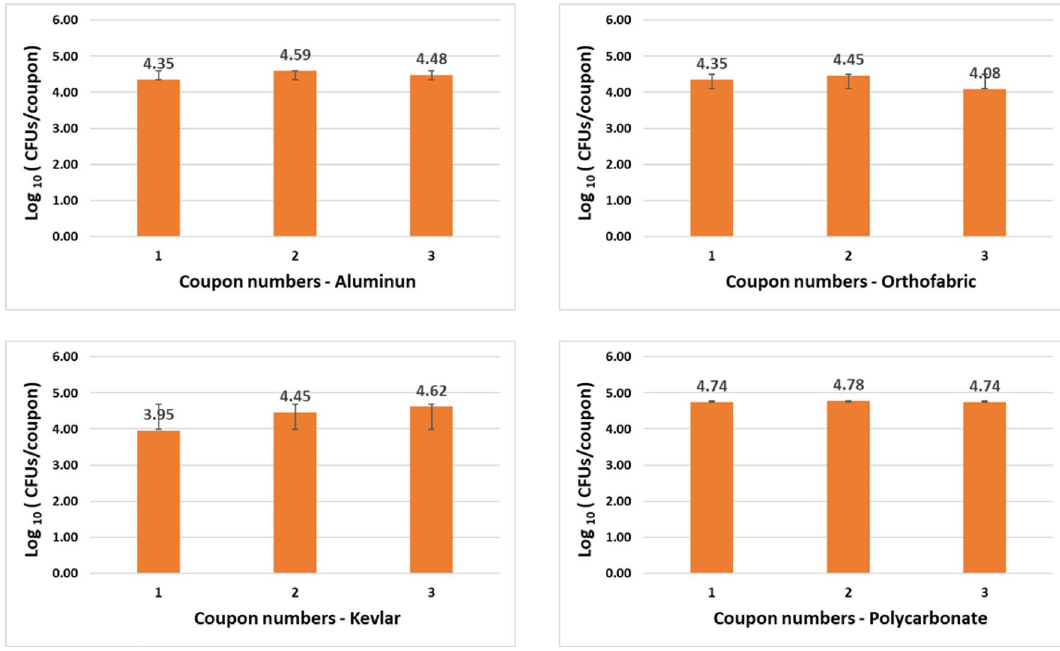
Figure 7. Data establishing consistent controls with E. coli inoculation, i.e., inoculating coupons of same material with same volume of E. coli culture resulted in consistent bacterial count per coupon with a maximum variation of 0.3 log10 (CFU/coupon).